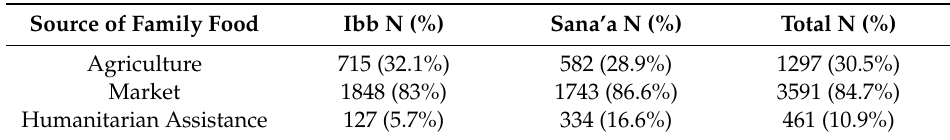
Table 6. Distribution of food sources among families in the target communities in Ibb and Sana’a by governorate (multiple answers possible).